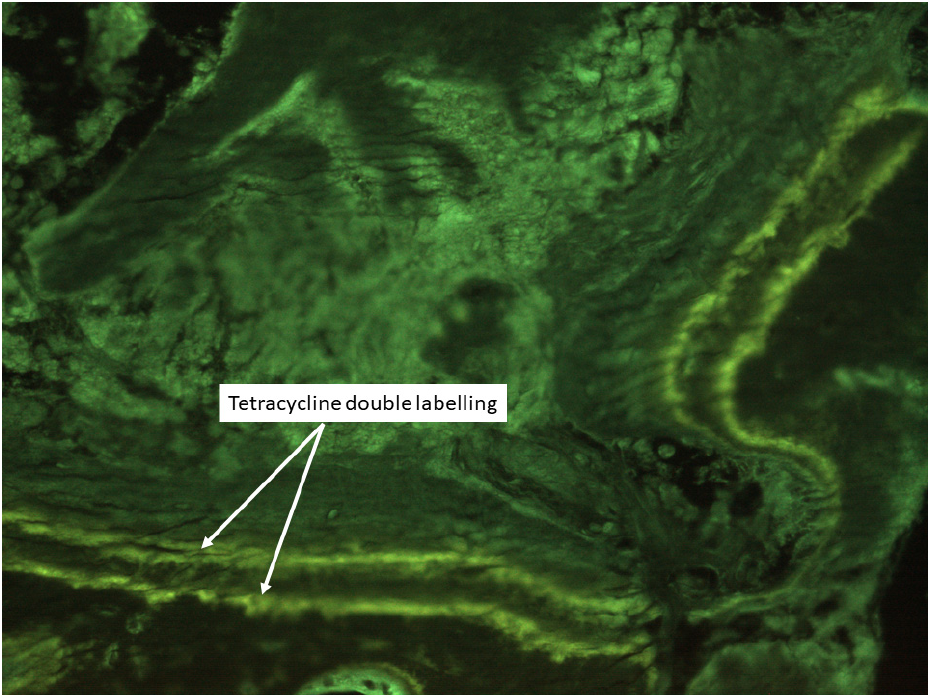
Figure 2. Example of double tetracycline labelling. The two green lines represent the mineralization surfaces while the Mineral Apposition Rate is the distance between the two lines expressed in microns. Table 1. The main literature on bone biopsy in recent